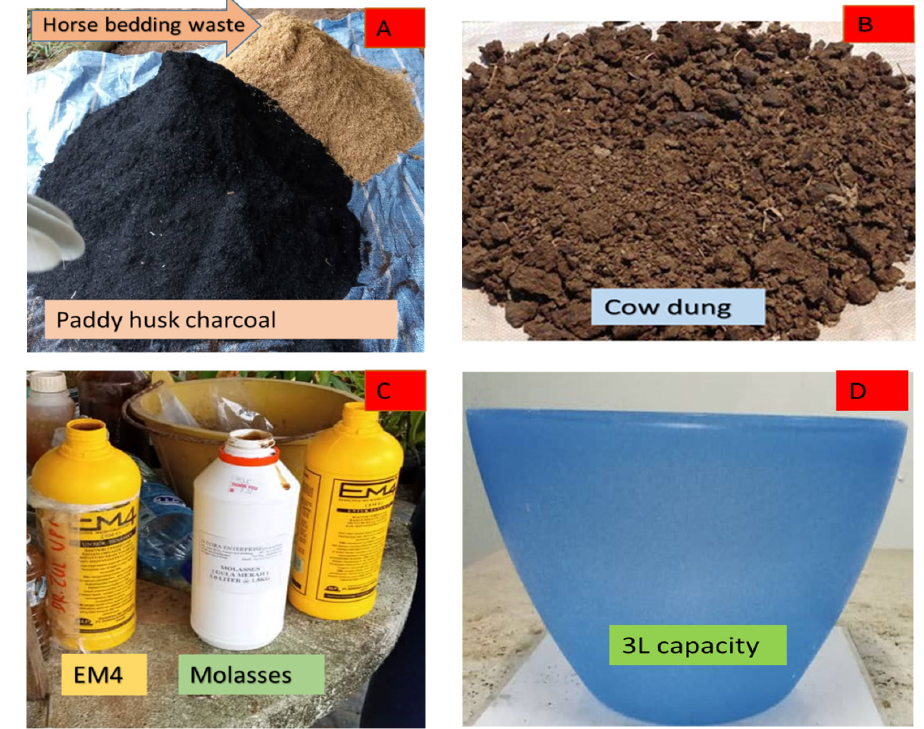
Table 1. Microbial count of the effective microorganism ‐ 4 (EM4) solution. Total Plate